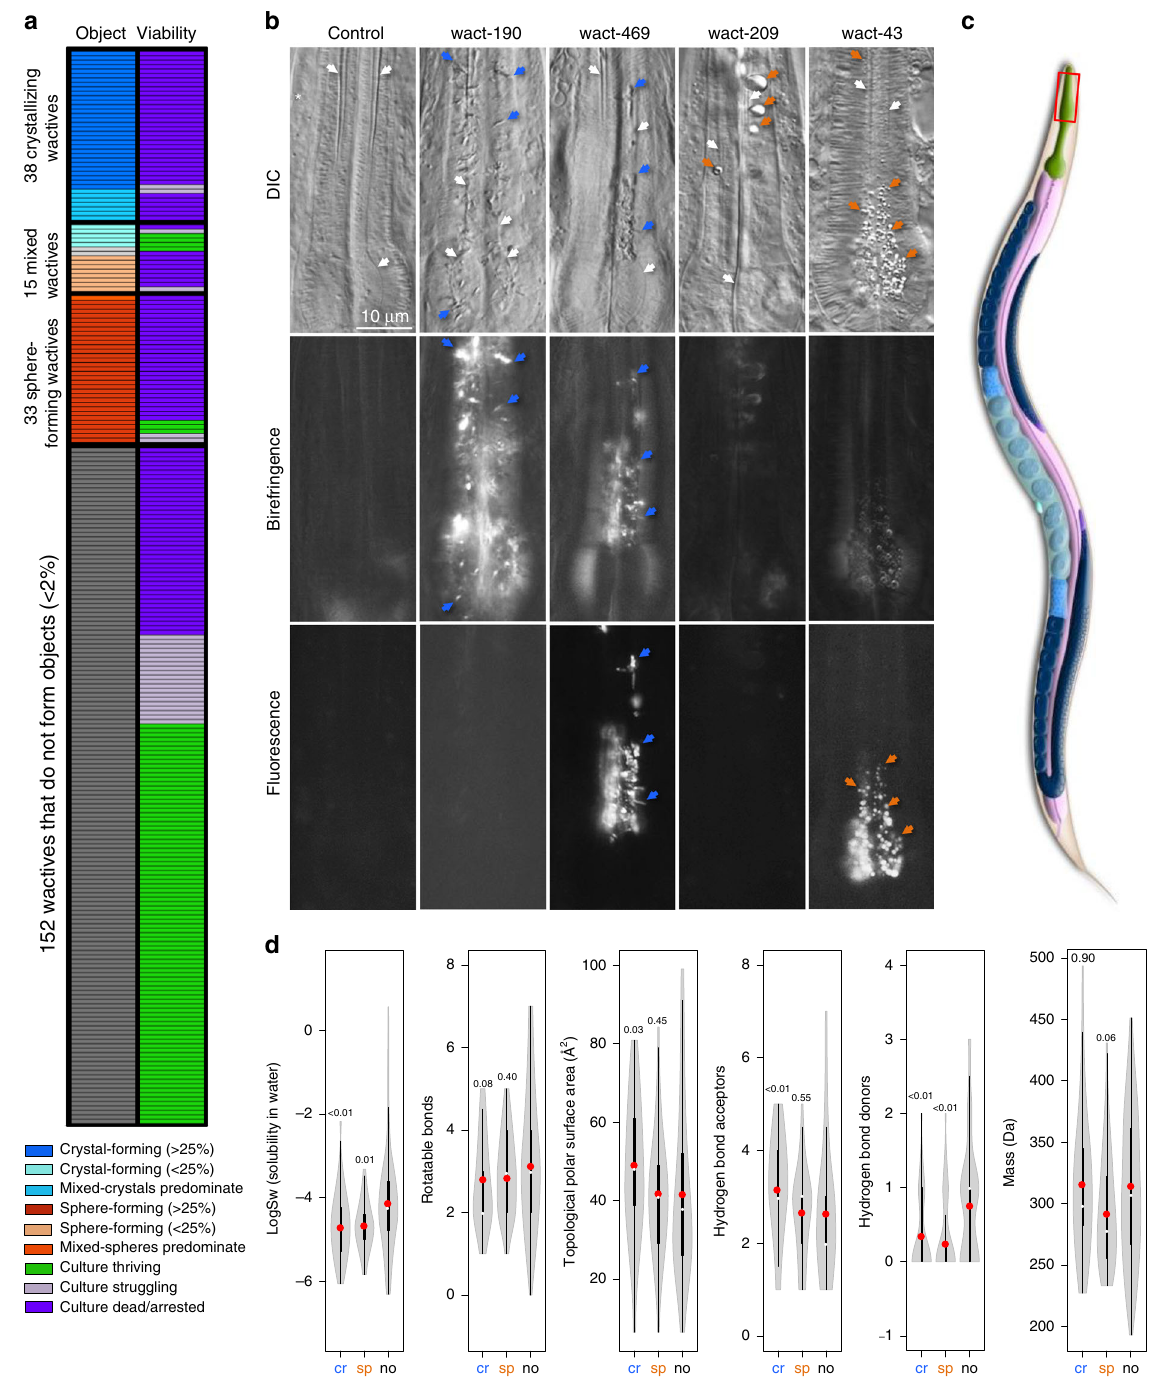
Fig. 1 Wactives can form objects in the marginal cells of the anterior pharynx. a A chart showing our survey of the effects of 238 wactives on C. elegans L1 animals. Each row is a distinct wactive. The fi rst column indicates whether a wactive accumulates as a crystal, sphere, or neither at a concentration of 30 μ M. The second column indicates whether the wactive also kills/arrests worm development at a concentration of 30 μ M. The percentages in the legend refer to the percentage of animals harboring the indicated objects. See “ Methods ” for details. b Examples of the accumulation of crystals and spheres in the anterior pharynx of young adults treated for 24h to allow easy visualization of the channels. The fi rst row shows differential interference contrast images; the second row shows whether the objects are birefringent (and therefore crystalline); and the third row shows whether the object fl uoresces. White arrows indicate the channels, blue arrows indicate crystals, and orange arrows indicate spheres. The white asterisk indicates where the micrograph was spliced to ensure channel is in the correct focal plane. The scale is the same for all panels. c A schematic of C. elegans (courtesy of WormAtlas). The anterior pharynx is boxed. d Violin plots of the physical – chemical properties of molecules that crystallize (cr) ( n = 38 distinct molecules), form spheres (sp) ( n = 33 distinct molecules), or fail to form objects in the animal (no) ( n = 152 distinct molecules). The gray shape represents all results and the thickness indicates how common that value is within the dataset; a white circle indicates the median; a red circle indicates the mean; the center thick line represents one standard of deviation; the thinner line represents the second standard of deviation. The number above each plot shows the signi fi cance of the difference compared to the “ no-object ” data using the nonparametric two-tailed Mann – Whitney U test. Source data for a and d are provided in the Source Data fi